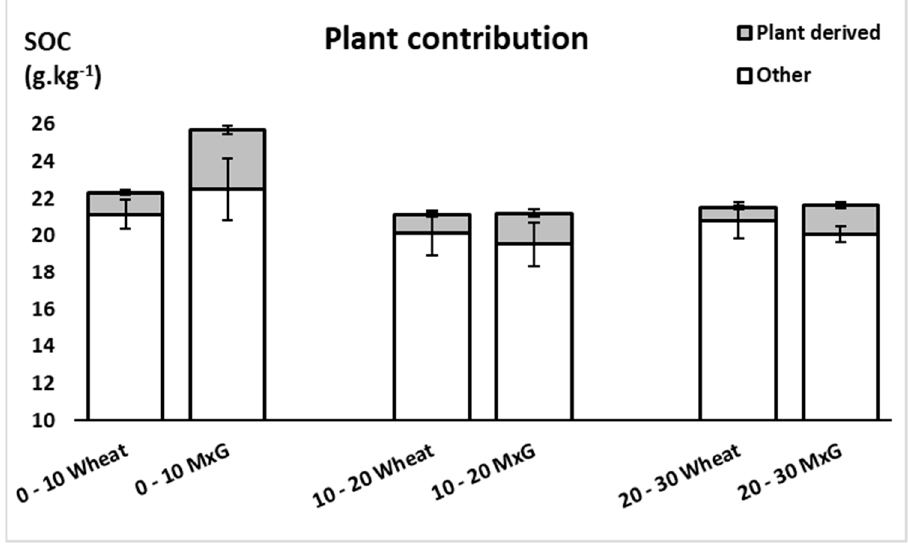
Figure 7. Miscanthus and wheat derived carbon content (g.kg − 1 ) at soil depths (0–10, 10–20 and 20–30 cm). Values are presented as means ±